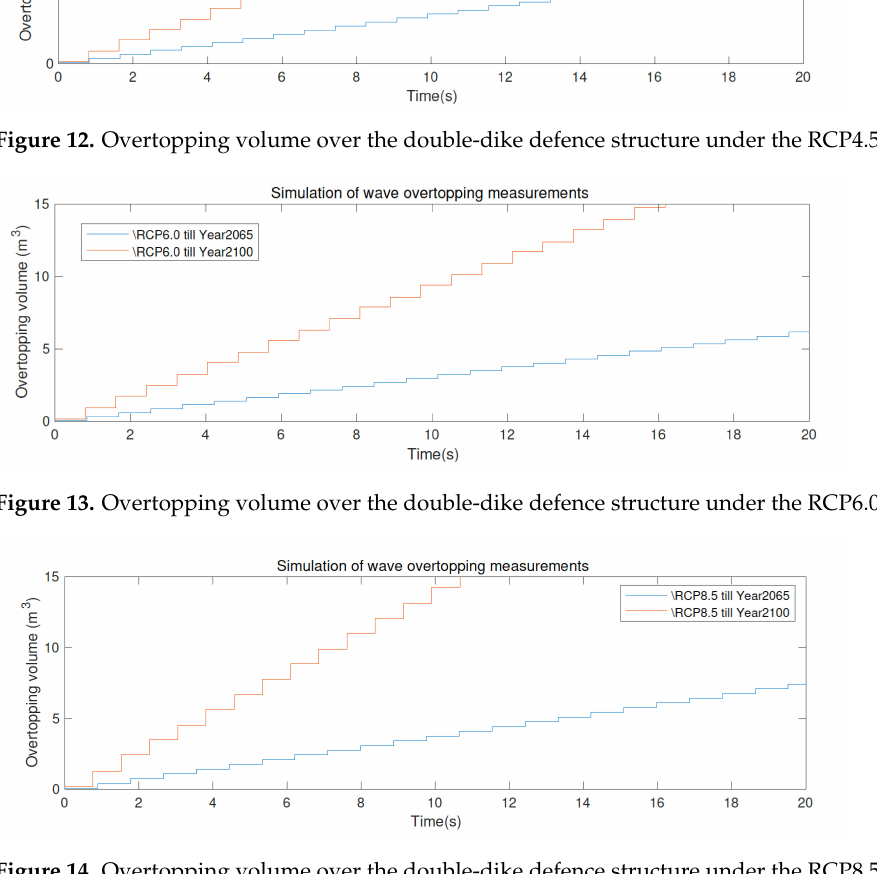
Figure 14. Overtopping volume over the double-dike defence structure under the RCP8.5